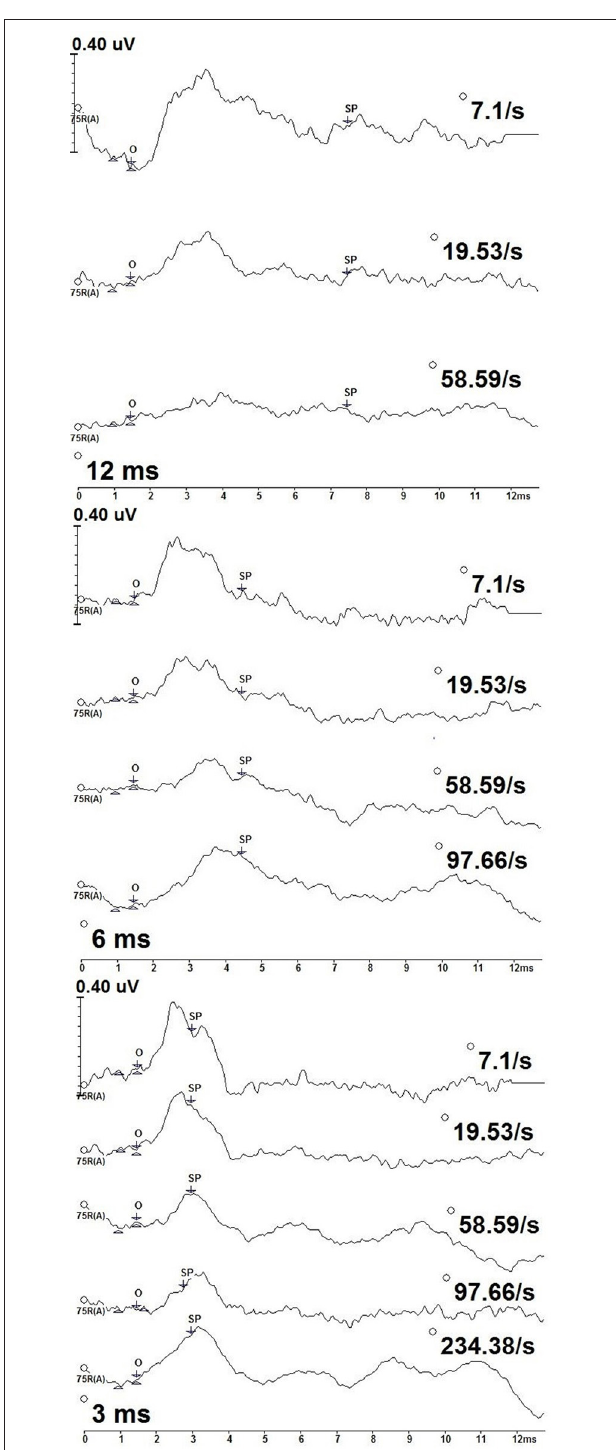
FIGURE 3 | CLAD deconvolved, 2,000 Hz tone burst ECochG measurements from one participant (P9) across stimulus duration (12 ms—top; 6 ms—middle; 3 ms—bottom). Responses to increasing repetition rate are displayed from top to bottom in each panel. SP amplitude was measured as the baseline at 1 ms to the SP waveform midpoint (SP). The SP waveform midpoint (SP) was measured from onset (O).